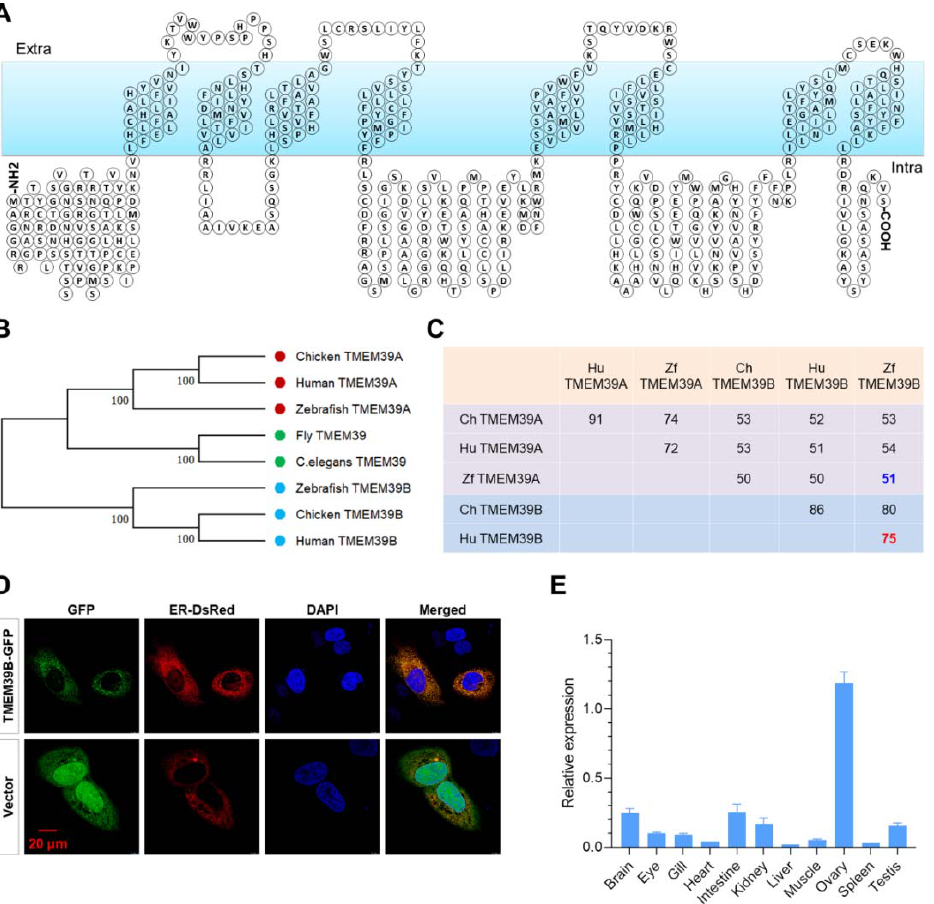
Figure 1. Molecular characteristics of zebrafish Tmem39b. ( A ) Predicted structure of zebrafish Tmem39b protein, which contains 8 transmembrane domains. ( B ) A phylogenetic tree of